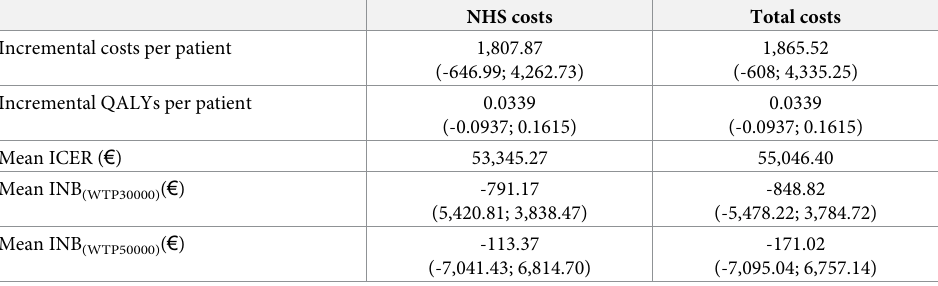
Table 3. Incremental costs per QALY (cost–utility analysis) of TM vs. CM